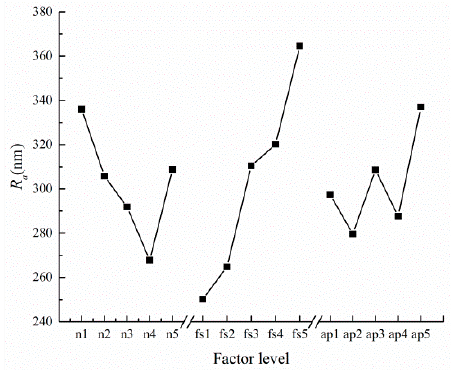
Figure 10. Factor and surface roughness tendency chart.